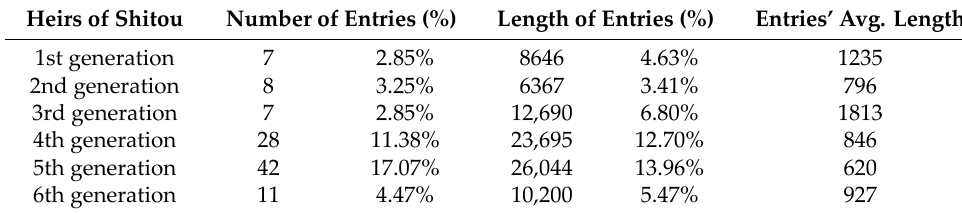
Table 5. Generations of successors to Shitou in the ZTJ .